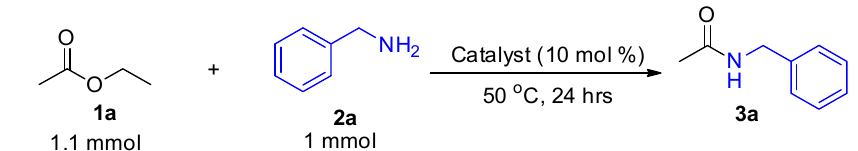
Scheme 1. Catalyst = AlCl 3 , FeCl 3 , FeCl 2 , FeBr 3 or BiCl 3 .